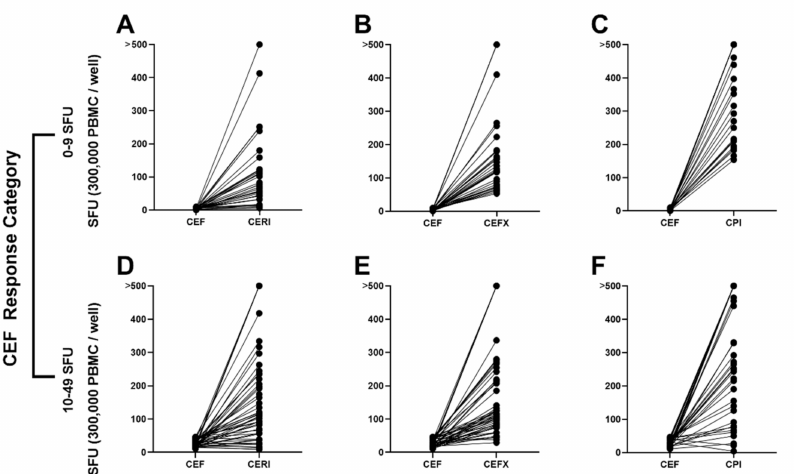
Figure 3. CERI-, CEFX-, and CPI-induced recall responses in CEF non-/low-responder PBMC. ( A – C ) Subjects whose PBMCs fell with <10 SFU/300,000 PBMCs into the CEF non-responder category (n = 49), or ( D – E ) with 10–49 SFU/300,000 PBMCs into the CEF low-category (n = 51) were tested in a standard 24 h IFN- γ ImmunoSpot ® assay for CERI ( A , D ), CEF-X ( B , E ) and CPI ( C , F ) recall at 300,000 PBMCs/well. SFU counts of the same PBMC are connected with a line.